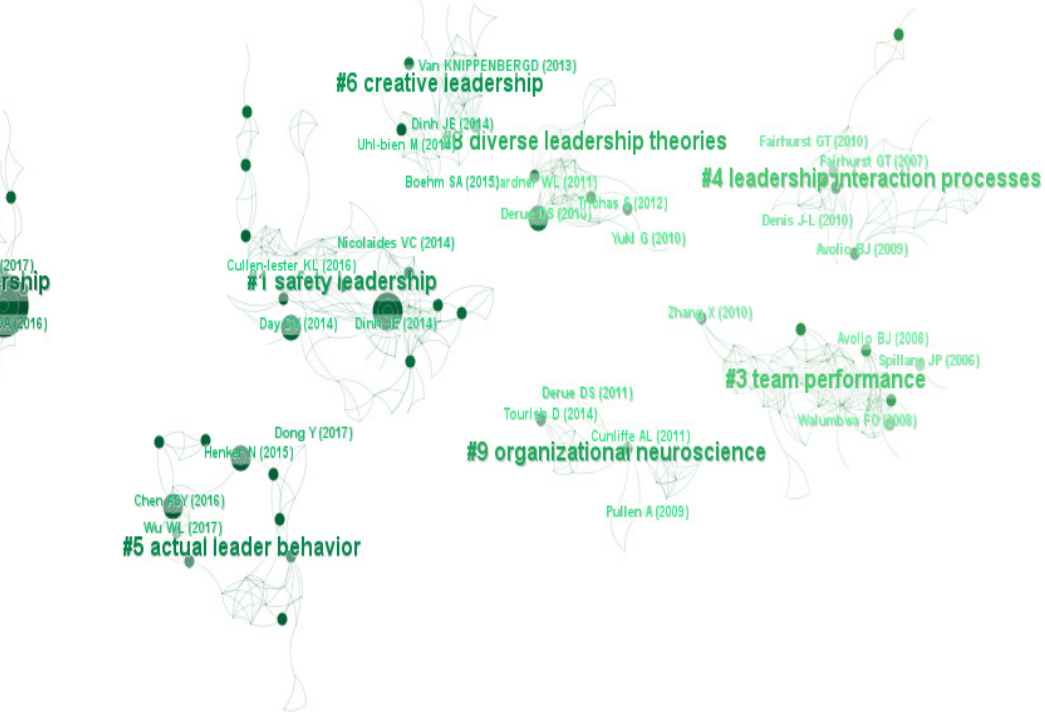
Figure 8. Reference co-citation network.